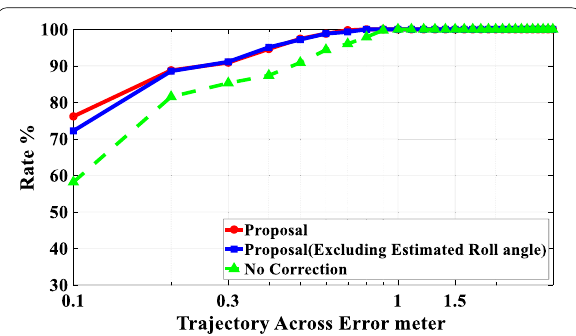
Fig. 20 Evaluation of vehicle trajectory (Urban street)